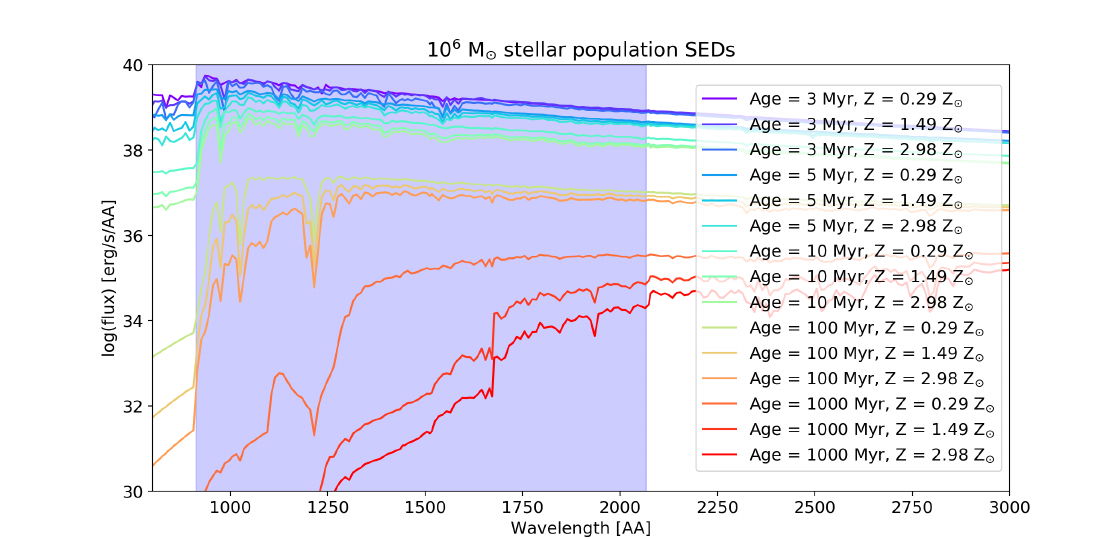
Figure 4. Example of SEDs for stellar populations of increasing age and metallicity, calculated with the starburst99 tool (see the text). A Kroupa IMF [112] at masses 0.1–100M (cid:12) was used together with an instantaneous burst of star formation which happened at age = 0 Myr. The Geneva high-mass loss tracks [113] were used. The shaded area indicates the region in wavelength used to integrate the SED for obtaining the FUV flux in e.g., Habing units [114], setting the chemical state of the gas. We note that comparing these models of different metallicities at the same age can be misleading, because stars of different metallicities have different lifetimes, i.e., a star of 3 Myr with solar metallicity will not be in the same evolutionary stage as a star of 3 Myr with 0.1 times solar metallicity.